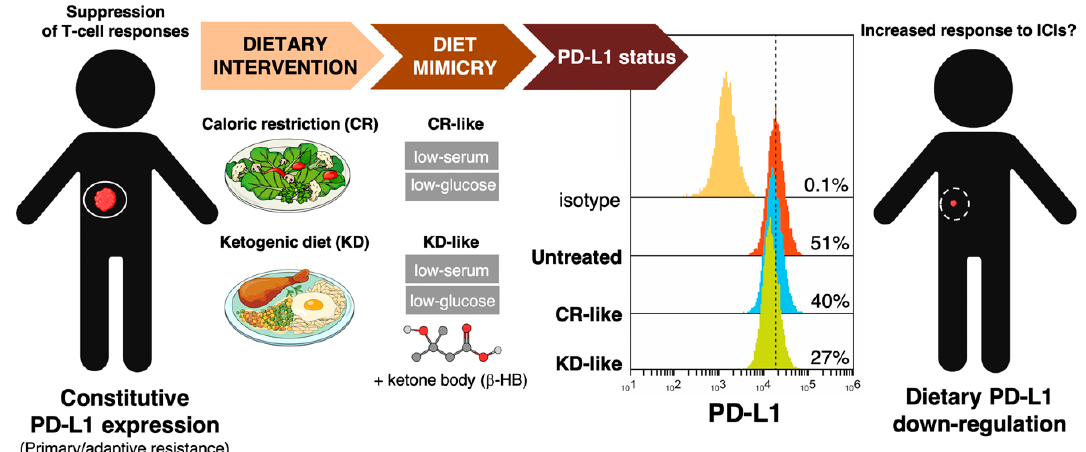
Figure 4. Ketogenic diet-mimicking culture conditions downregulate constitutive PD-L1 overexpression in biologically aggressive breast cancer cells. Tumor cells constitutively overexpressing immunosuppressive cell surface ligands such as PD-L1 may actively suppress anti-tumor T-cell functionality. To evaluate the impact of short-term fasting / ketogenic diet (KD)-like metabolic conditions on the constitutive expression of PD-L1, we used the basal-like / HER2-positive breast cancer cell model JIMT-1 which overexpress PD-L1 in 100% of the cells [122]. Although whether such a constitutive PD-L1 expression results in decreased or increased likelihood of responding to programmed death-1 (PD-1) / PD-L1-targeted immune checkpoint inhibitors remains to be determined, PD-L1-overexpressing JIMT-1 cells are intrinsically unresponsive to T-cells (unpublished observations). To mimic the physiological state of metabolites found in the circulation of patients treated with KD-like dietary interventions, we performed experiments in the presence of 2 mmol / L of the ketone body β -hydroxybutyrate ( β -HB)—representing β -HB plasma concentration levels achieved under a KD or short-term fasting conditions (range 2–6 mmol / L)—and low (2.5 mmol / L) glucose levels to avoid an undesirable pathophysiological ketoacidosis. Such KD-mimicking physiological conditions reduced the expression of cell-surface-associated PD-L1 by approximately